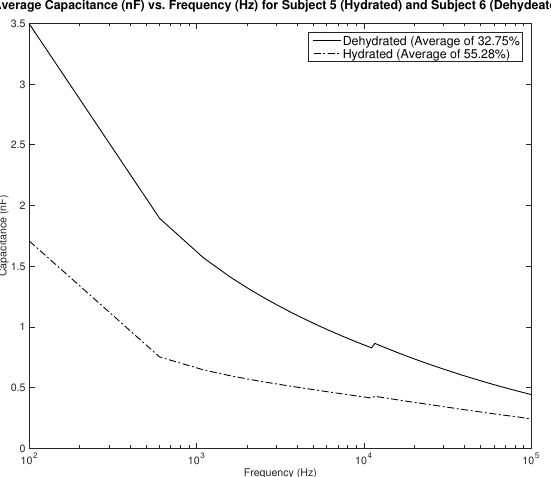
Figure 19. Testing results—capacitance (nF) vs. frequency (Hz): comparison between average measurement of hydrated and dehydrated subjects (Both Female).